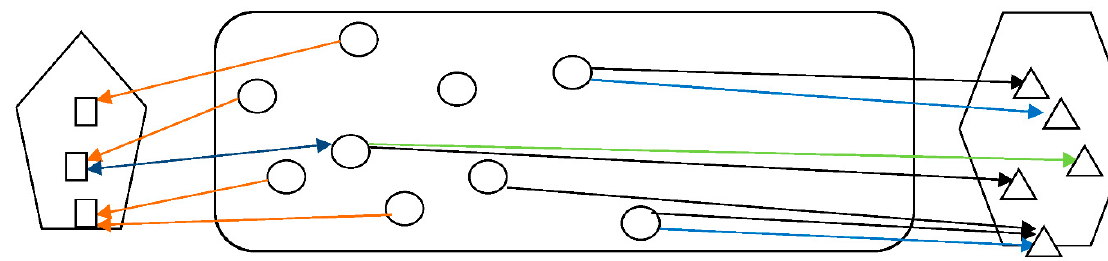
Figure 3. Conceptual space with intermediate relations of concepts.